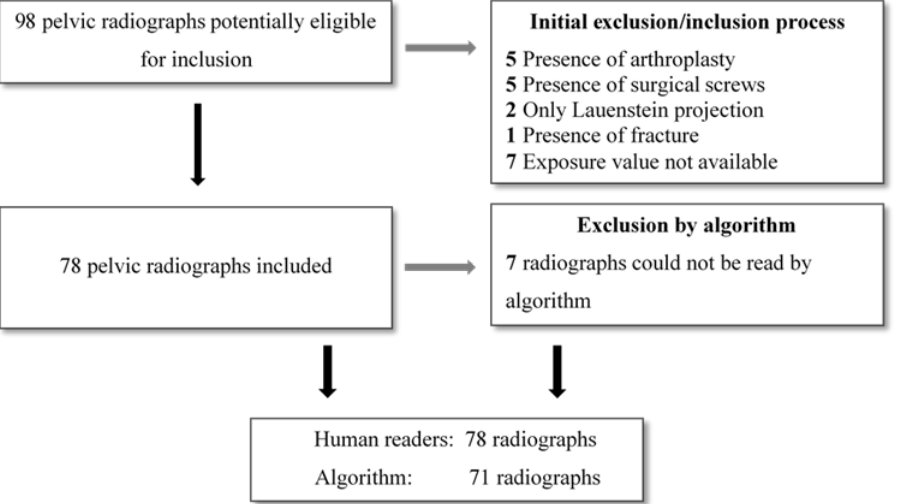
Figure 1. Flow-chart describing the screening process according to inclusion/exclusion criteria. In total, 98 pelvic radiographs were screened until the desired sample of 78 radiographs was achieved.